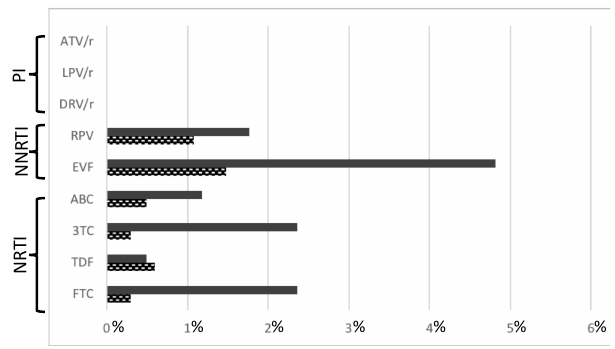
Figure 4. Predicted phenotypic resistance (Standford scores) for antiretroviral drugs currently recommended as first line therapy in Portugal for drug naïve patients. Hight level resistance (Stanford scores > 3; bold bars indicate a score of 5. Checked bars indicate a score of 4, related with a first line antiretroviral drugs recommended by the European AIDS clinical society. Abbreviations: NRTIs = Nucleoside reverse transcriptase inhibitors; NNRTIs = Non-nucleoside reverse transcriptase inhibitors; PIs = Protease inhibitors; FCT = Emtricitabine; TDF = Tenofovir; 3TC = Lamivudine; ABC = Abacavir; EVF = Efavirenz; RPV = Rilpivirine; DRV / r = Darunavir; LPV / r = Lopinavir; ATV / r = Atazanavir.